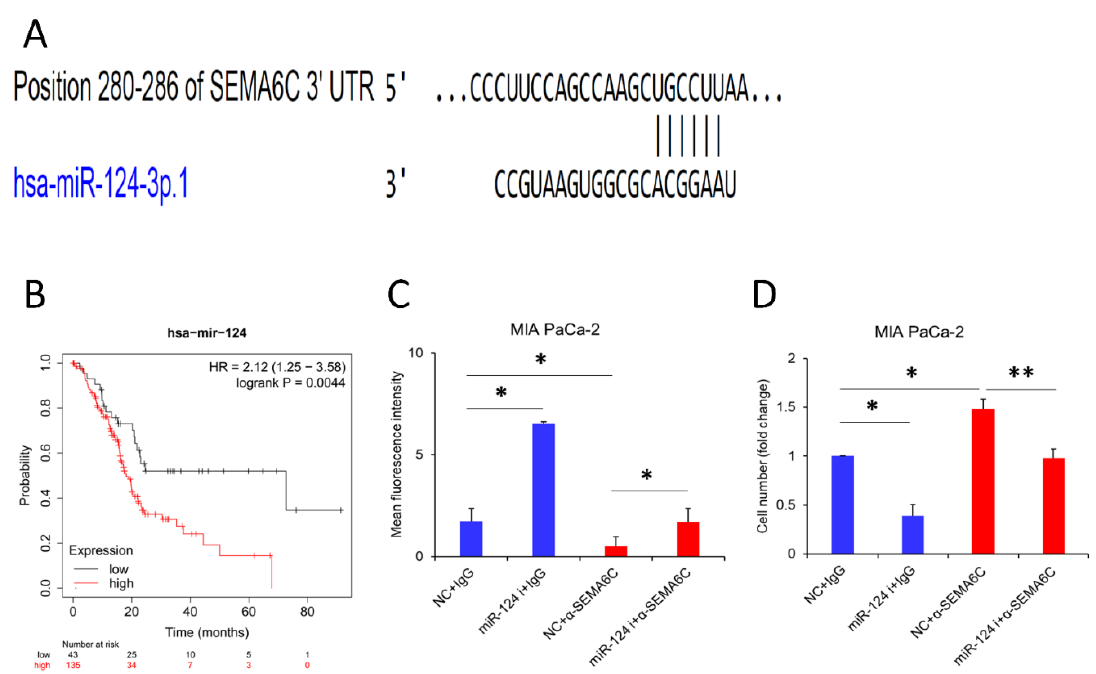
Figure 6. The miR-124-3p inhibitor suppresses pancreatic cancer proliferation via SEMA6C upregulation. miRNAs targeting SEMA6C were identified by overlapping predicted miRNAs from miRDB, TargetScan, and miRWalk. The targeting of SEMA6C by miR-124-3p ( A ) and the prognosis prediction by this miRNA in pancreatic cancer ( B ) are shown. The effect of miR-124-3p inhibitors on SEMA6C expression ( C ) and proliferation ( D ) in MIA PaCa-2 was analyzed. * represents p < 0.05, ** represents p < 0.01.